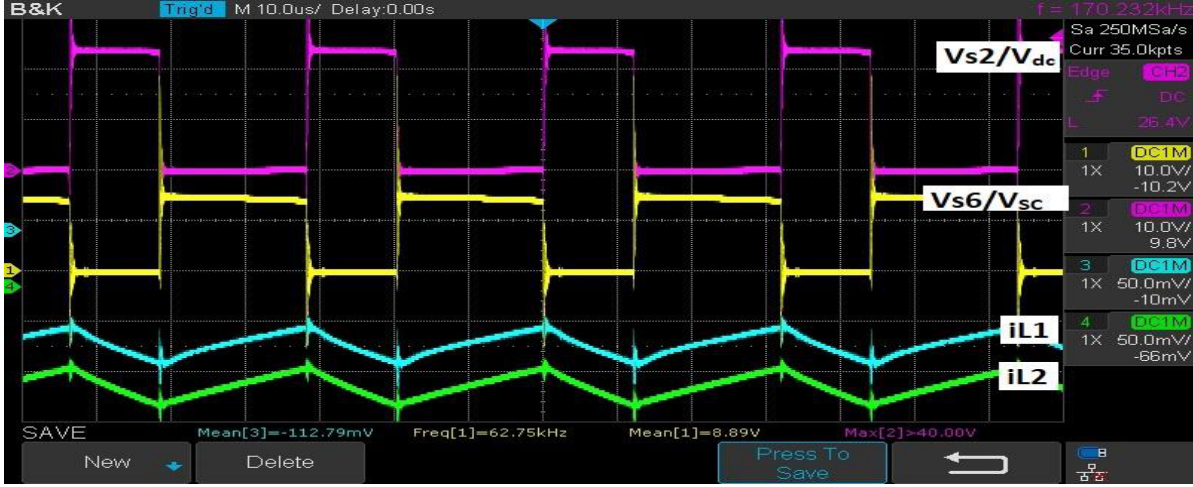
Figure 22. Simultaneously charging the battery and supercapacitor from the DC link in mode 5.